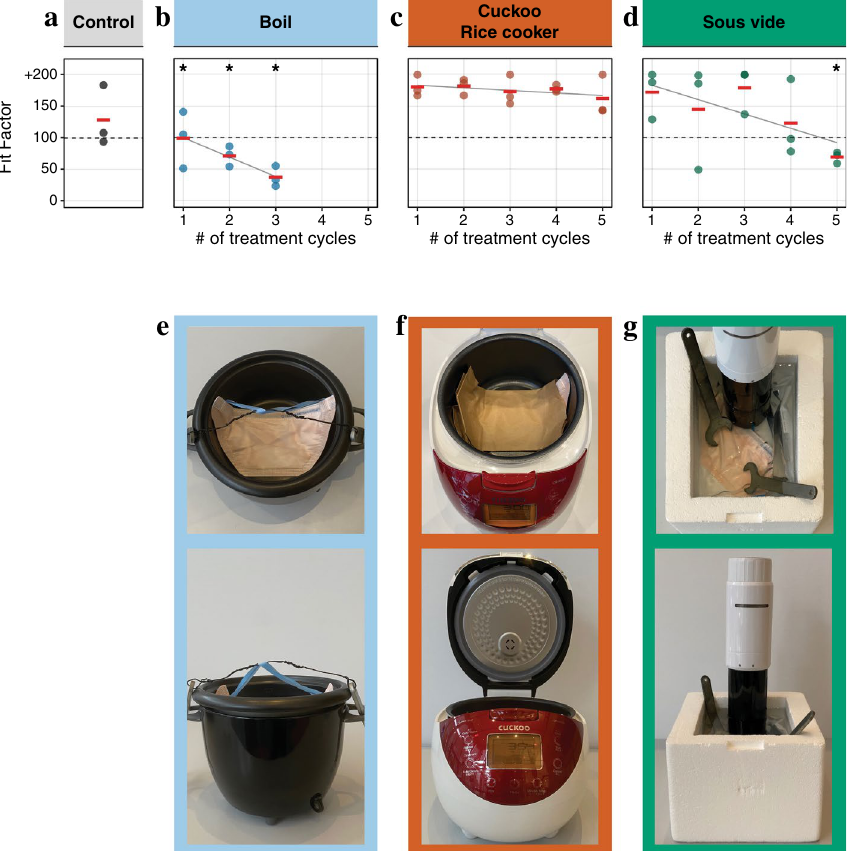
Figure 2. Average Halyard Fluidshield 3 FFR fit factor before and after treatment. Fit factor as a function of treatment cycles for each condition. Photograph of the heat generation appliance shown in the panel below their respective fit factor profile: ( a ) control, ( b , e ) boiling, using ( c , f ) a rice cooker and ( d , g ) a sous vide machine. Fit factor measures were repeated three times for each FFR (individual dots) and average fit factor is reported to the nearest integer (red bar). Grey regression lines quantify fit factor as a function of the number of treatment cycles. Asterisks indicate significant differences in fit between treatment group and control (ANOVA, p <